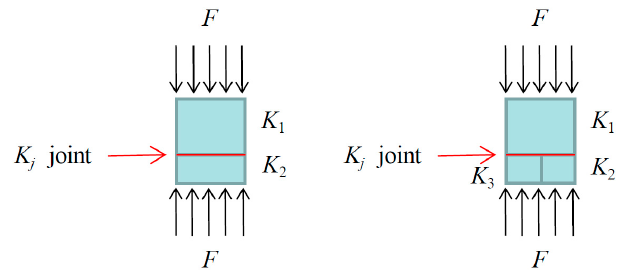
Figure 5. Schematic diagram of the grouping of supporting slates in the lower part of the roof plate The method of direct contact between the strips and the top plate can be mainly di- Figure 6. Sketch of equivalent support sti ff ness calculation Figure 6. Sketch of equivalent support stiffness Figure 6. Sketch of equivalent support sti ff ness calculation vided into two basic forms: series and parallel connection, as shown in Figure 6.